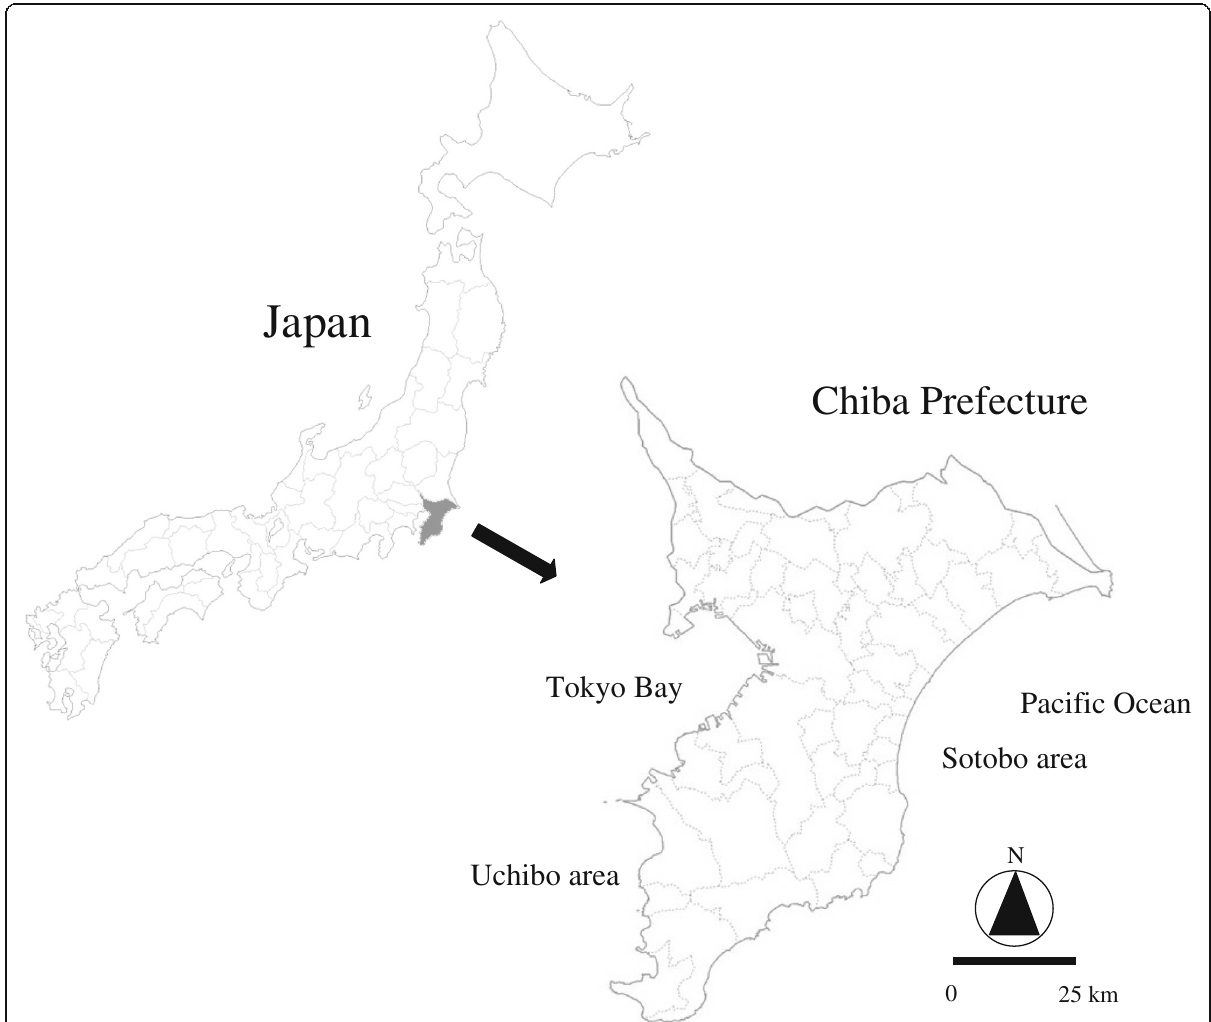
Fig. 1 Study area. Light gray lines indicate municipal boundaries in Chiba Prefecture in 2017. Base map from the Geospatial Information Authority of